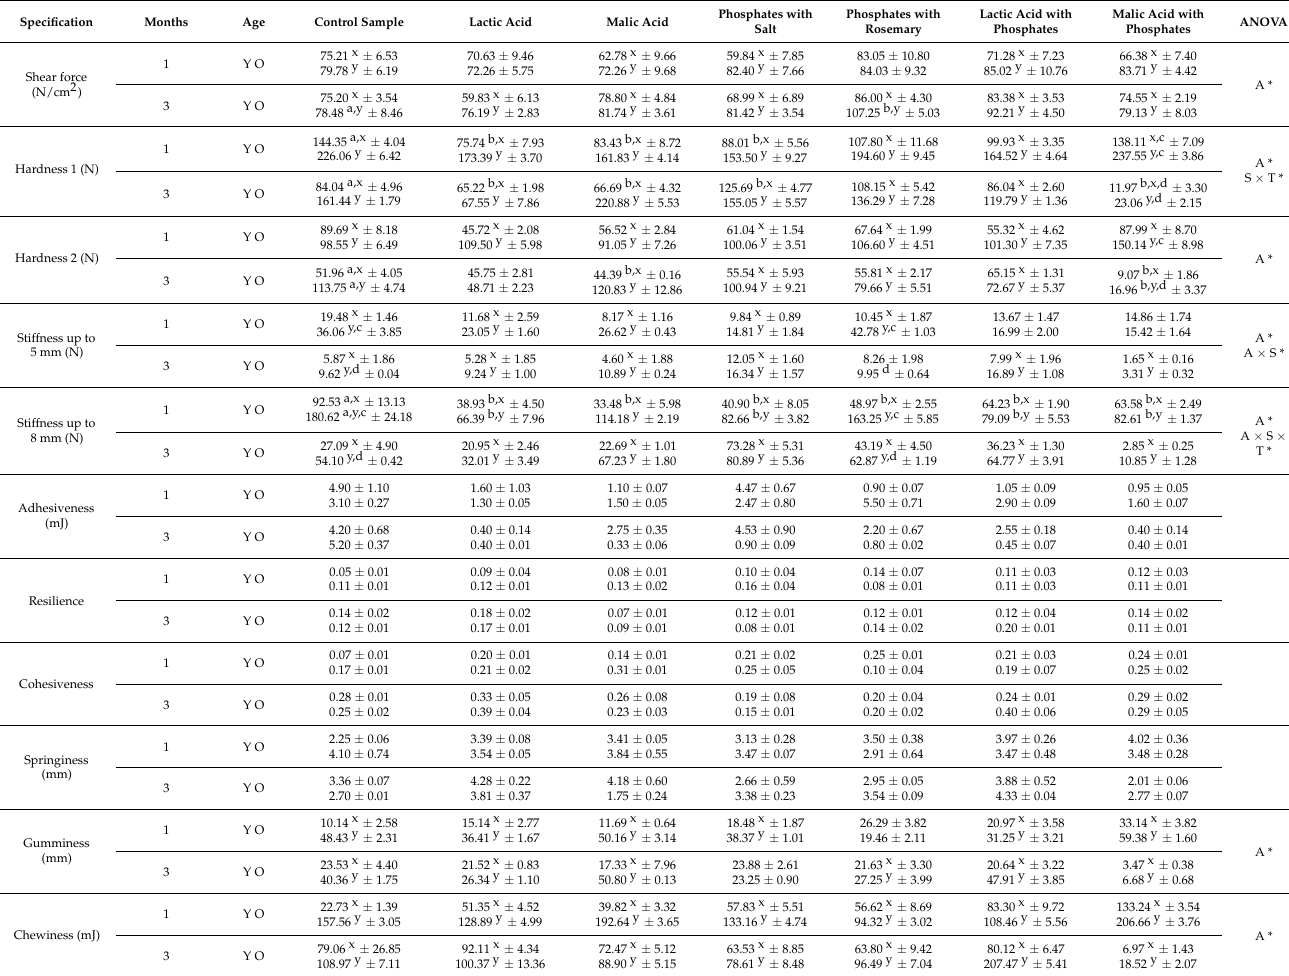
Table 3. Texture parameters of the tested horse meat samples (from each age group: 12 carcasses × 2 parts of muscle samples × 7 steaks = 168 samples of steaks) (%, x ±